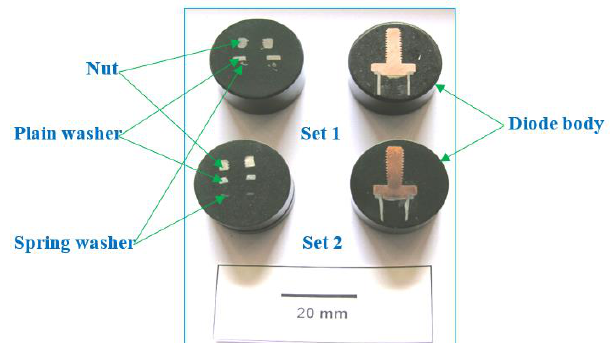
Figure 5: Cross-sectional samples after mounting in bakellite hot mount.